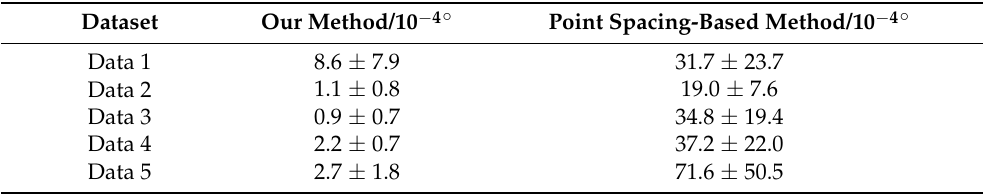
Table 3. Estimation error of horizontal angular resolution on each dataset (Mean ± Std).